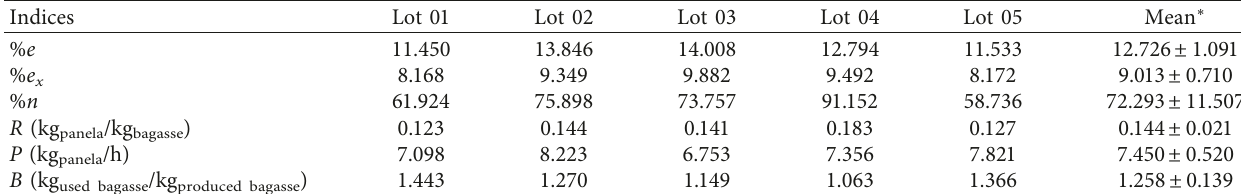
Table 4: Efficiency, productivity, and environmental indices for the traditional furnace.